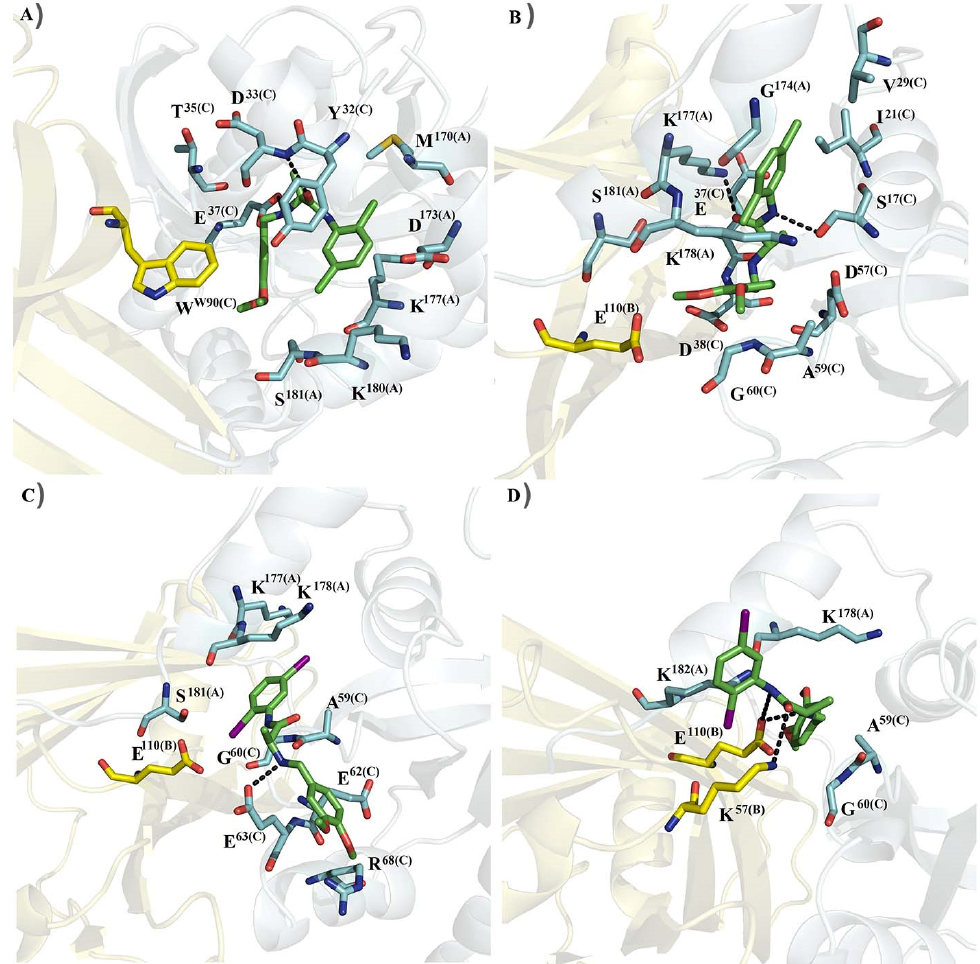
Figure 2. Most frequent conformations of C19 and I-C19 within the K-Ras4B–PDE6 δ (cyan–yellow) complex during the MD simulations: ( A ) K-Ras4B–PDE6 δ –C19; ( B ) K-Ras4B G13D –PDE6 δ -C19; ( C ) K-Ras4B–PDE6 δ –I-C19; ( D ) K-Ras4B G13D –PDE6 δ –I-C19. Labels A, B and C denote residues from HVR2, PDE δ and K-Ras4B, respectively. The dotted lines represent hydrogen bonds.